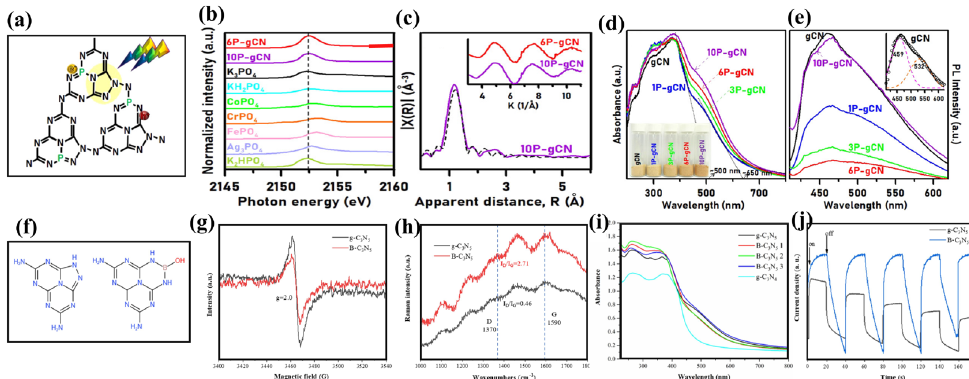
Figure 8. ( a ) Doping structure of P-C 3 N 5 ; ( b ) K-edge XAFS spectra of 6P-gCN, and 10P-gCN samples and phosphorus reference compounds; ( c ) FT of the k 2 -weighted EXAFS spectrum (purple line) and the curve fitting result for the 10P-gCN sample (dotted line). Inset shows the k 2 -weighted EXAFS spectra; ( d ) UV-vis; ( e ) PL spectra; ( f ) A schematic illustration of B-C 3 N 5 ; ( g ) ESR spectra; ( h ) Raman spectra; ( i ) UV-vis DRS spectra; and ( j ) the transient photocurrent response. ( a–e ) Adapted with permission from [36]. Copyright American Chemical Society, 2021. ( f–j ) Adapted with permission from [37]. Copyright Elsevier B.V., 2022.